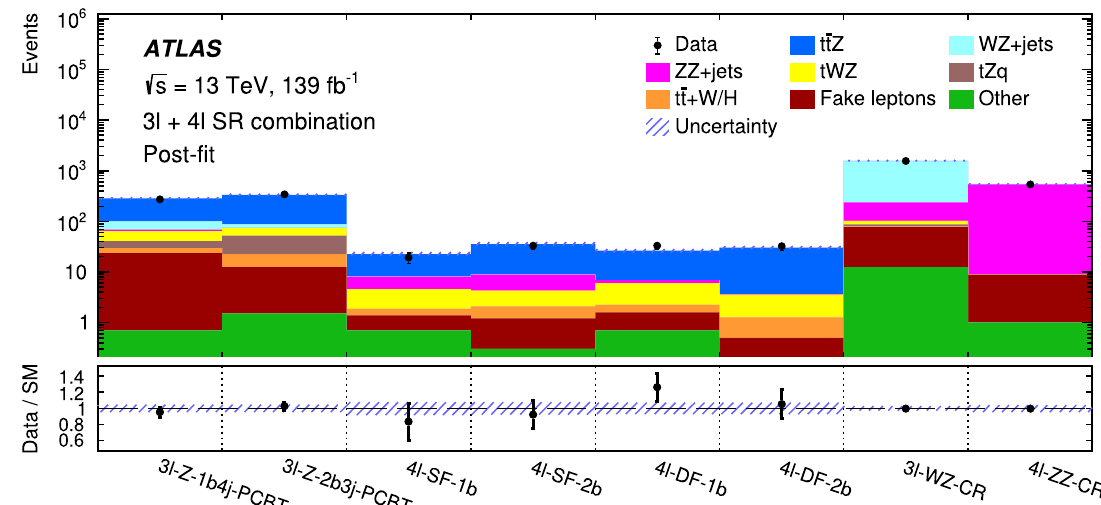
Fig. 3 The observed and expected event yields in the trilepton and tetraleptonsignalregions,aswellasthe W Z / Z Z + jetscontrolregions, after the combined fit. The bottom panel shows the ratio of data to the